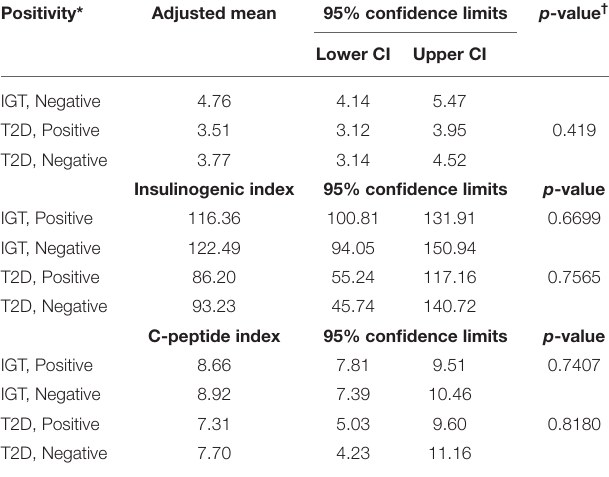
Adjusted means for values at month 12 visits. All models are adjusted for age, sex, race/ethnicity, treatment group, and baseline value of dependent variable. All models except for BMI are also adjusted for baseline BMI. Models for SSCP, ACRPg, and ACPRmax are also adjusted for baseline and month-12 insulin sensitivity (M/I). Analyses for M/I, SSCP, ACPRg, and ACPRmax performed using the log value. * Positivity over 12 months: Negative results are negative at baseline and month-12 samples. Positive responses are positive at either baseline, 12 months, or baseline and month-12.